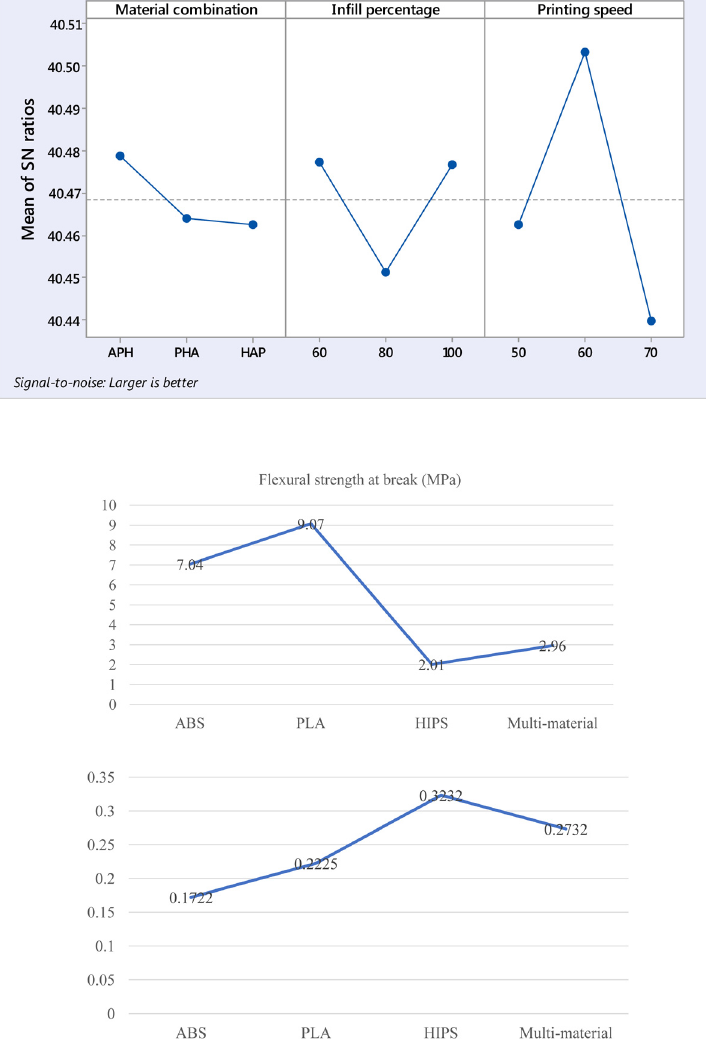
Figure 21. Thermal conductivity of 3D printed component at predicted